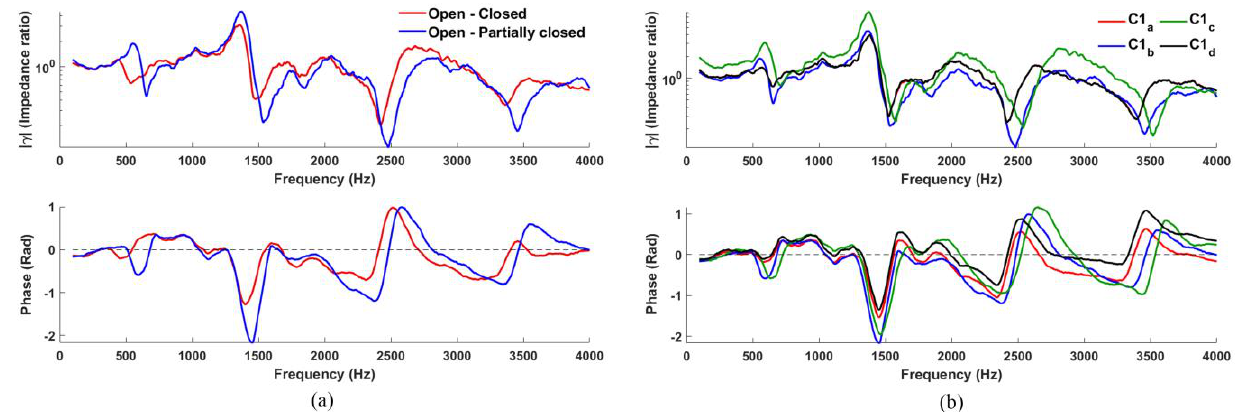
Figure 4. ( a ) Measurement of configuration 1 for “glottis” completely and partially closed; ( b ) four typical γ(f) measurements made on a 170 mm pipe using configuration 1, magnitude above and phase below; resonances are indicated in both magnitude and phase plots at approximately 590, 1450, 2370, and 3350 Hz with less than 2% disagreement.